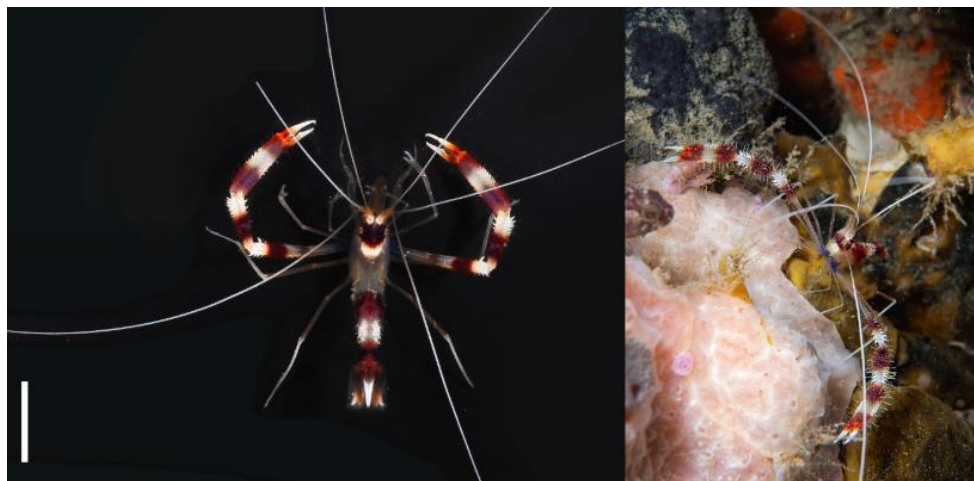
Figure 26. Stenopus hispidus (Olivier, 1811) [23]. ( Left ): M (AWMM MA182117). Scale bar = 2 cm (Image credit: Sadie Mills, NIWA). ( Right ): live specimen in Houhora Harbour, Northland (Image credit: Crispin Middleton, Seacology NZ).